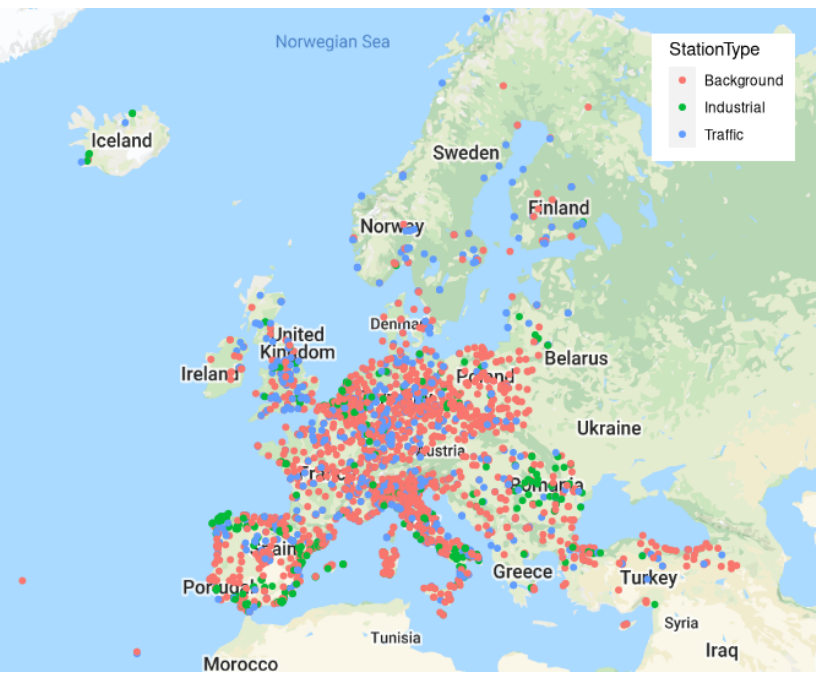
Figure 2. Locations of monitoring stations in complete EU air quality dataset, coloured by site category.